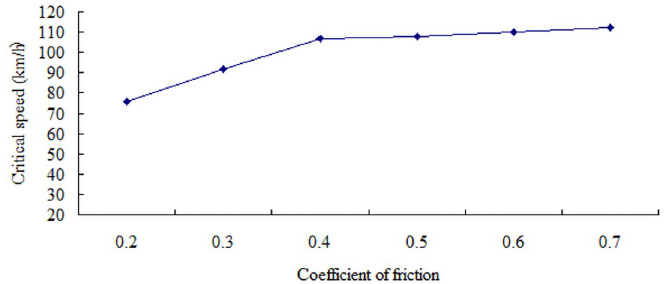
Fig 7. Graph between critical speed and coefficient of friction of sideslip.